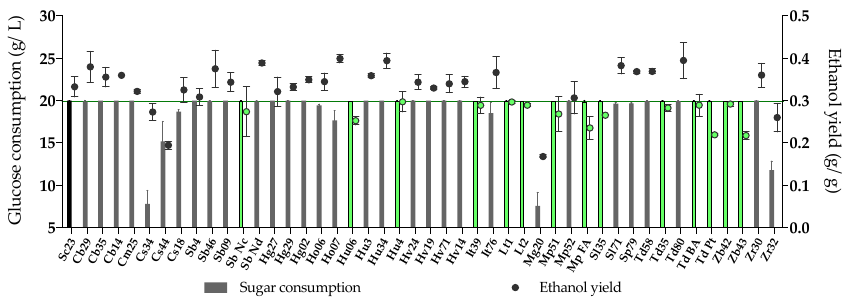
Figure 1. Glucose consumption (g / L) and ethanol yield (ethanol production (g / L) / sugar consumption (g / L), g / g) of 45 non- Saccharomyces yeasts and Sc23 (control yeast) after 3 days fermentation in YPD medium. The non‐ Saccharomyces yeasts selected for the next step are colored in green (glucose consumption > 19.90 g/L and ethanol yield ≤ 0.30 g/g). The value of the green line is 0.30 g/g (10% ethanol reduction of Sc23).